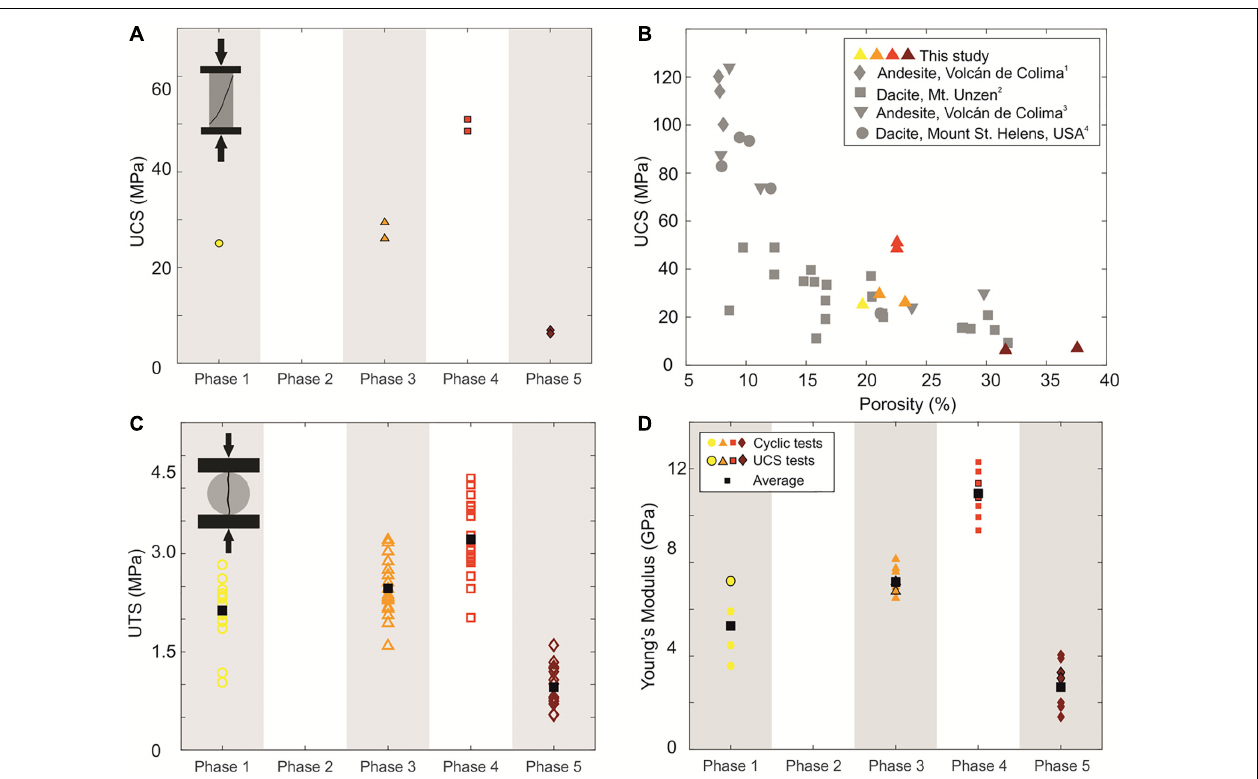
FIGURE 8 | (A) UCS results. UCS is highest in Phase 4, and lowest in Phase 5, while Phases 1 and 3 are intermediate. (B) UCS as a function of porosity, compared with published datasets from other dome-building volcanoes: 1 Heap et al., 2018a (diamonds); 2 Coats et al., 2018 (squares); 3 Heap et al., 2014a (downward triangles); 4 Kendrick et al., 2013 (circles); (C) Tensile strength determined by Brazilian disk testing for samples from eruptive Phases 1, 3, 4, and 5. Each measurement is shown by the hollow markers, with mean tensile strength for each eruptive Phase shown by the black squares. (D) Young’s modulus ( E ) determined from both UCS and cyclic tests performed on 26 mm diameter cores and shown by Phase with averages shown for each Phase (black squares). Young’s modulus is determined using stress/strain between 40 and 50% of the UCS strength value, from the linear portion of stress/strain curve where we assume elastic